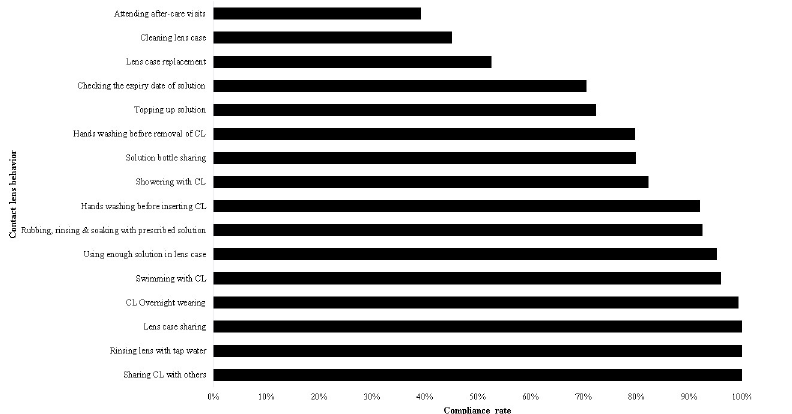
Fig 1. Compliance rate of contact lens behaviors observed in the study sample (n =